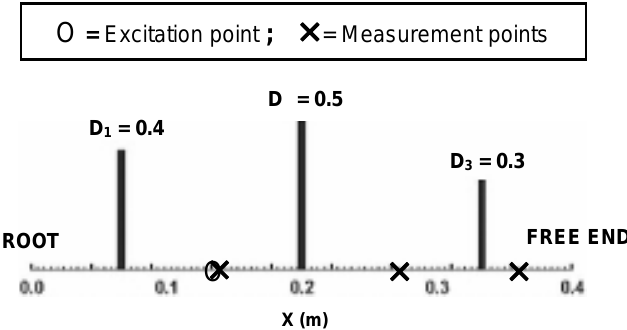
Fig. 3. Numerical example for the feasibility tests of the present reduced-domain method: a cantilevered beam with three local